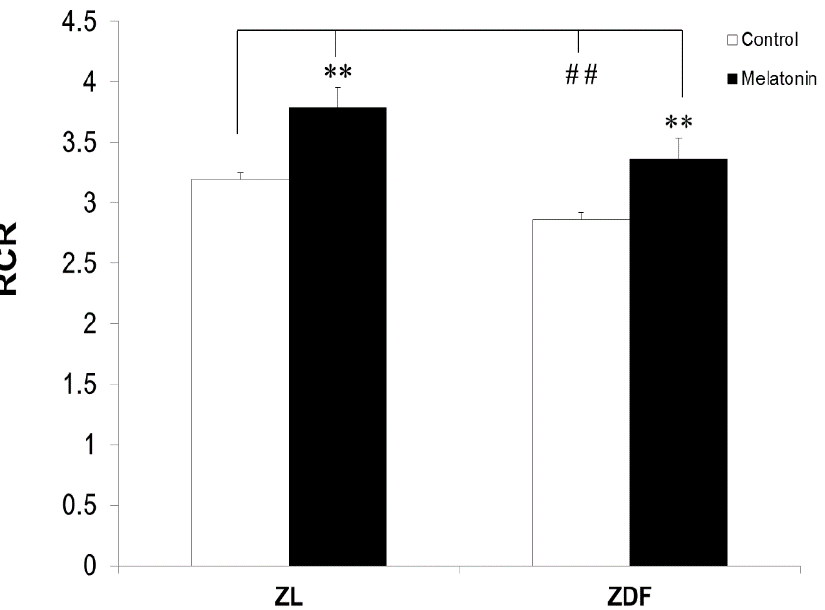
Figure 2. Respiratory control ratio (RCR) of mitochondria isolated from brown adipose fat depots of control (untreated) and melatonin-treated ZDF and ZL rats. RCR was defined as the ratio of state 3 to state 4. Data are shown as mean ± SD. ZL, Zücker lean rats; ZDF, Zücker diabetic fatty rats. Superscript characters indicate significant differences determined by two-way ANOVA followed by the Tukey post hoc test ( ** p < 0.01, M-ZDF compared with C-ZDF and M-ZL compared with C-ZL animals; ## p < 0.01, C-ZDF and M-ZDF compared with C-ZL